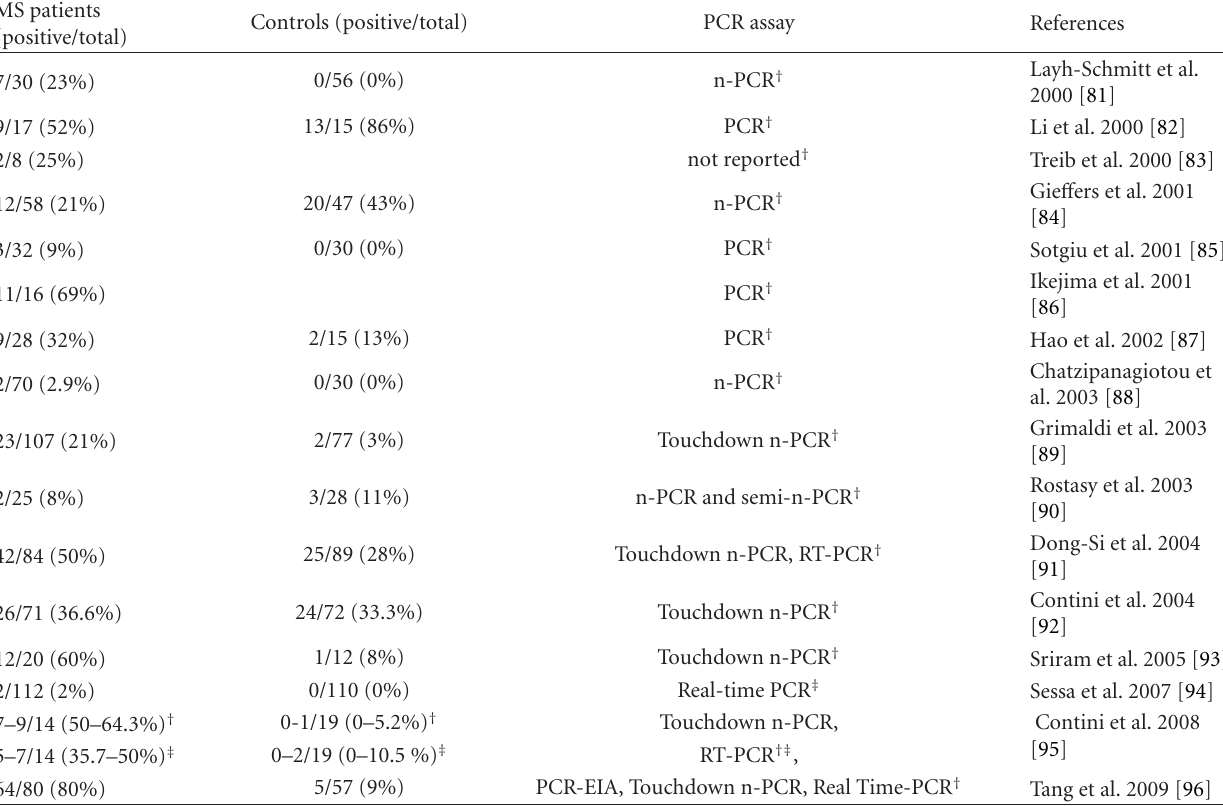
Table 2: Molecular protocols employed for detection of C. pneumoniae in clinical specimens from MS patients. MS